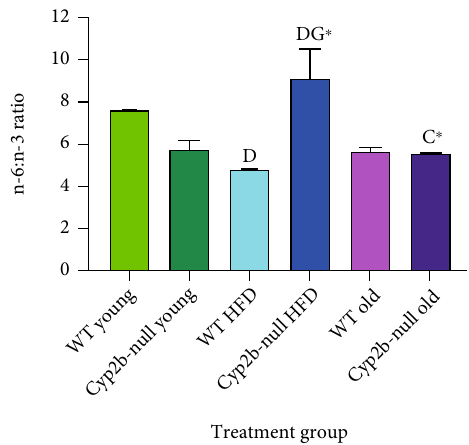
Figure 5: Changes in n-6:n-3 ratios between treatment groups. Data are presented as mean ð g Þ ± SEM . Statistical signi fi cance was determined by one-way ANOVA multiple comparison test with Tukey ’ s as the post hoc test ( n = 3 − 5 ). “ a ” indicates age di ff erence between young (4.5mo) and old (9 mo) mice within the same genotype and diet group, “ c ” indicates di ff erence between HFD-fed young (4.5 mo) and ND-fed old (9 mo) mice within same genotype, “ d ” indicates diet di ff erence between ND-fed and HFD-fed mice within in same genotype and age, and “ g ” indicates genotype di ff erence between WT and Cyp2b-null mice within same diet and age group. No asterisk indicates a p value < 0.05, and ∗ indicates a p value <